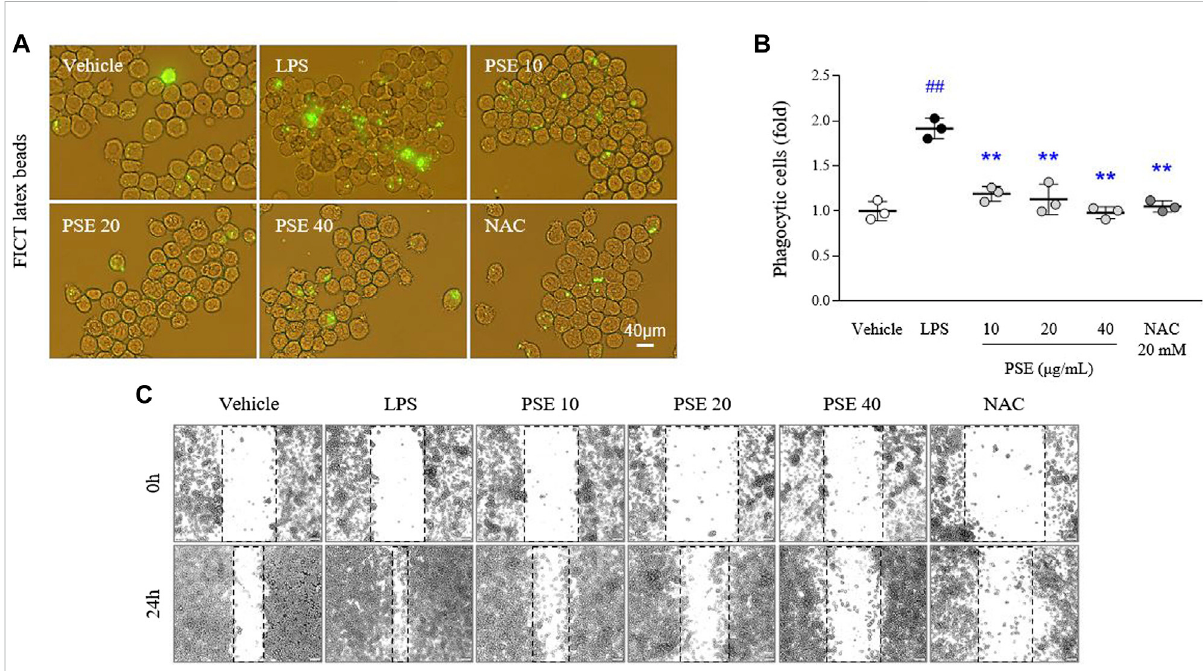
FIGURE 4 Phagocyticandmigratory activities.Phagocyticactivitywasassessedusingaphagocytosis fl uorescentassayKit(IgGFITC) (A) ,anditsintensities were semiquantifed (B) . Cells were scratched with a pipette tip, and then wound images were obtained at 0 h (i.e., immediately after scratching) and 24 h (C) . The data are expressed as the mean ± SD. ## p < 0.01 compared with the vehicle-treated cells; ** p < 0.01 compared with the LPS- stimulated cells.